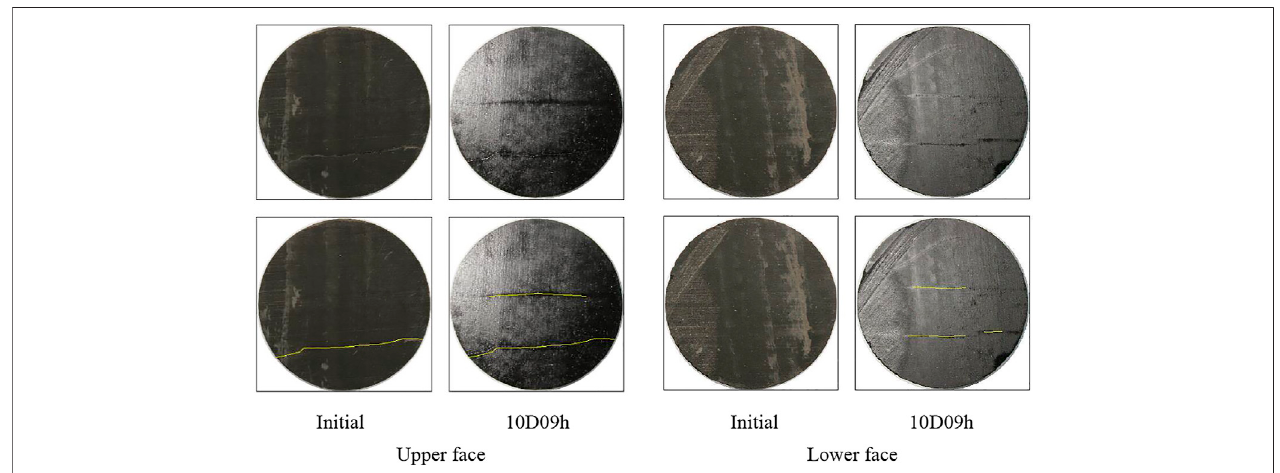
FIGURE 5 | Crack evolution process in mineral oil (J-3-2).